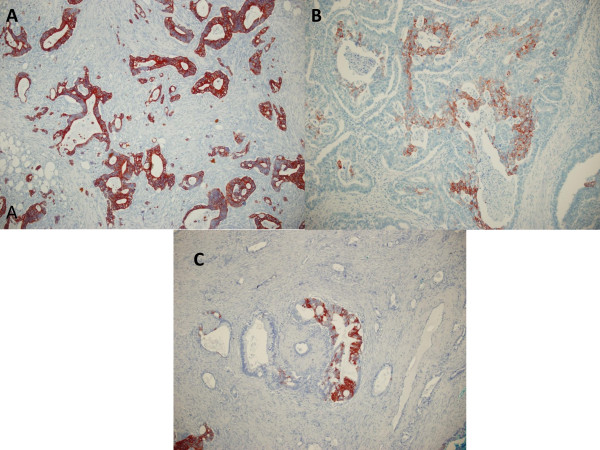
CK20 staining in colorectal, gastric, and pancreatic adenocarcinomas. (A) Colorectal adenocarcinoma displayed diffuse and strong immunoreactivity in the cytoplasm of cancer cells. (B) Gastric and (C) pancreatic adenocarcinomas exhibited focal cytoplasmic staining for CK20. Original magnification × 100.